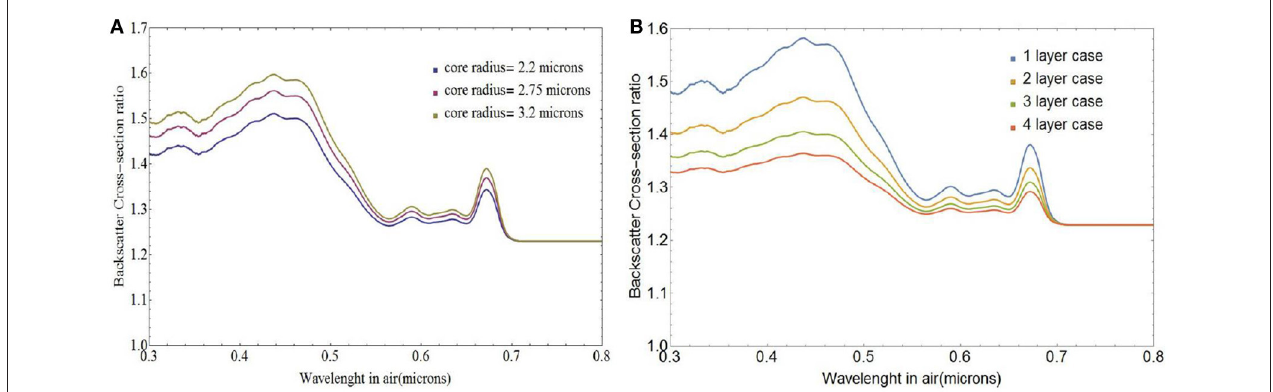
FIGURE 6 | Ratio of free coccolith to coated coccolithophore backscattering cross-section σ bbNl /σ bbs , for (A) single-layer coated coccospheres of varying core radii and (B) coccospheres with varying number of coccolith layers and a core radius of 3.0 µ m.